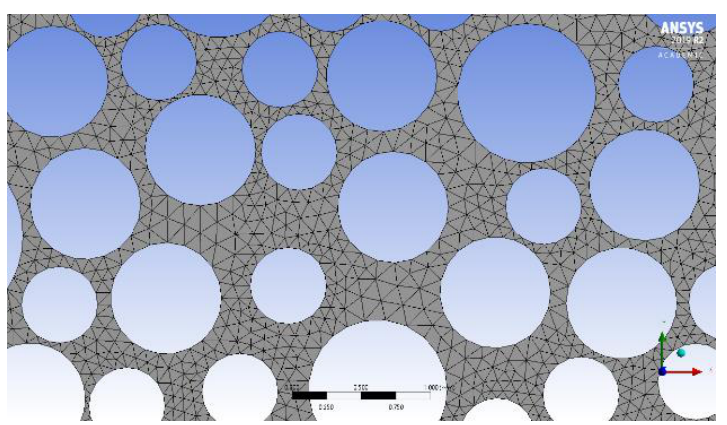
Figure 4. A closer view of the mesh built with triangular cells.